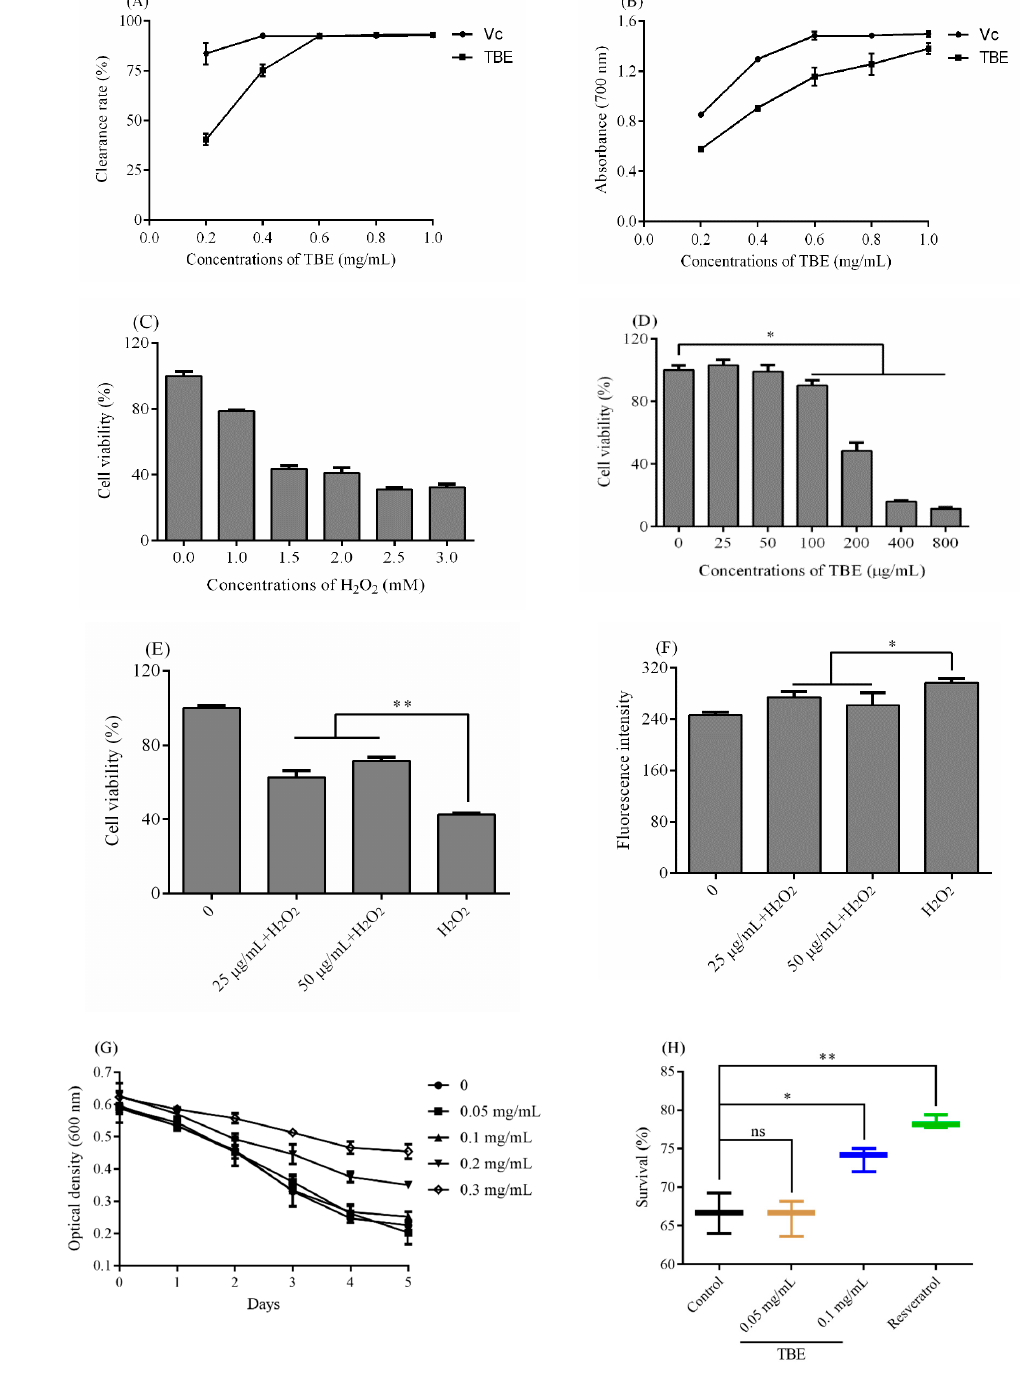
Figure 3. The antioxidant ability of triterpenes from B. emeiensis (TBE). ( A ) The clearance rate on 2,2-Diphenyl-1-picryl-hydrazyl (DPPH) radicals and ( B ) the total reducing power. ( C ) The oxidative damage model of CHO cells induced by H 2 O 2 . ( D ) The cell viability of CHO cells after treated with di ff erent concentrations TBE for 48 h. ( E ) The injury protection of TBE on CHO cells against on H 2 O 2 . ( F ) The fluorescence intensity of CHO cells after dying with 10 µ M 2 (cid:48) 7 (cid:48) -dichlorofluorescin diacetate (DCFH-DA). ( G ) The food clearance result and ( H ) the survival of worms under antioxidant stress. Note: * means < 0.05 and ** means < 0.01, and “ns” means not